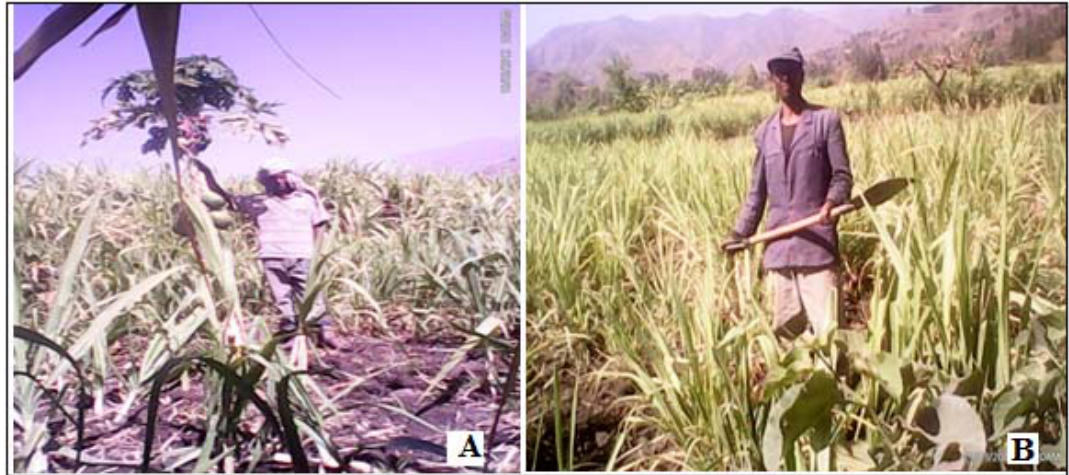
Figure 7. Photo graphs showing group discussion with the beneficiary households of Gedober irrigation scheme ( A and B ) March 2014.